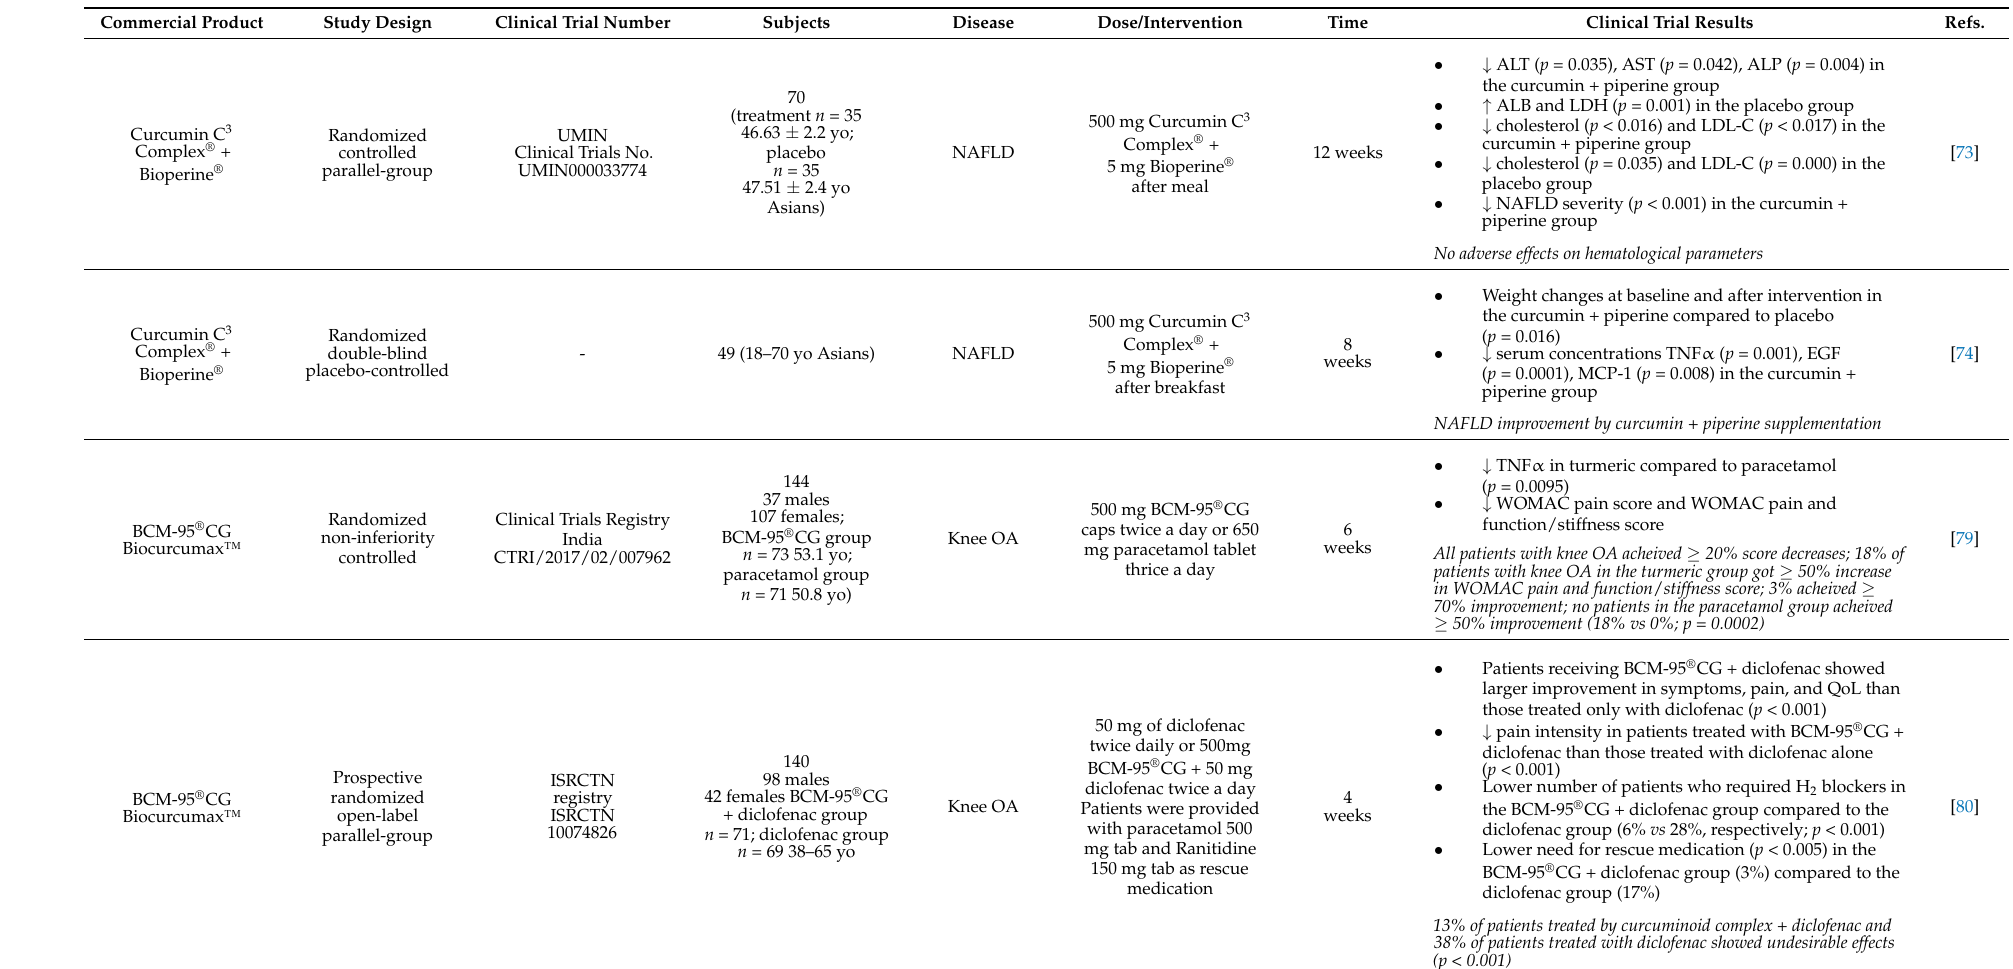
Table 2. Clinical studies of curcumin considering various curcumin-based